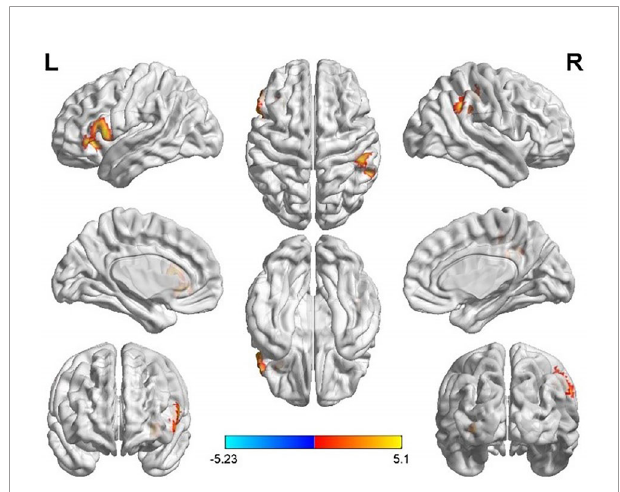
FIGURE 2 | Differences in left middle frontal gyrus (MFG.L) based FC between women with polycystic ovary syndrome and controls (the peak level threshold was set at p = 0.001; cluster level FWE-corrected, p < 0.05). The FC strength was increased and marked in